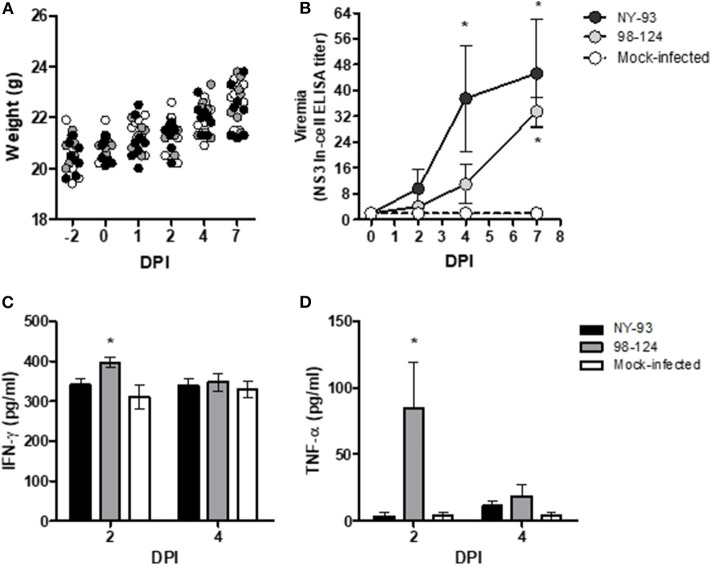
Mouse-BVDV–infection model. BALB/c mice were infected with two ncp BVDV genotype-2 strains, 98-124 and NY-93. In the figure, body weight (A); viremia (B); and the levels of the cytokines IFN-γ (C) and TNF-α (D) in pg/ml are plotted as functions of the time in days post-infection (DPI). Key to the point and bar textures: black, primary antibody against the NY-93 BVDV strain; gray, primary antibody against the 98-124 BVDV strain; white, mock-infected mice. The asterisks (*) denote values significantly higher than those measured in the mock-infected mice (p < 0.05).